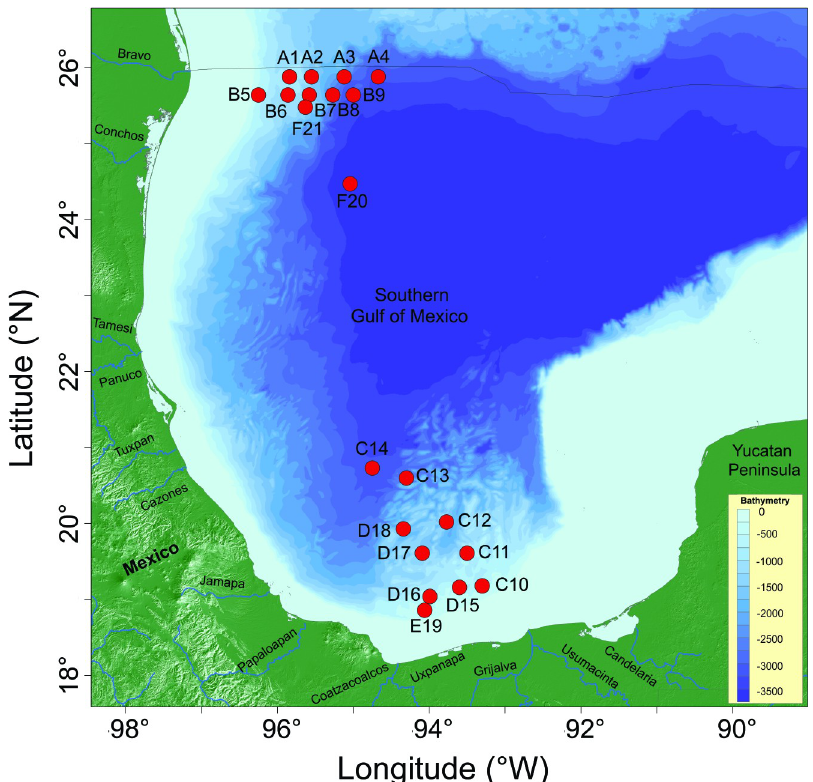
Fig 1. Study area in the Southern Gulf of Mexico (SGoM). Location of the study regions (Perdido and Coatzacoalcos) in oceanic waters over the continental slope ( > 500 m isobaths) and the deep region ( > 1,000 m) of the Southern Gulf of Mexico (SGoM). The nominal stations for the phytoplankton sampling conducted during " Malla Fina " (MF) cruises are shown for both